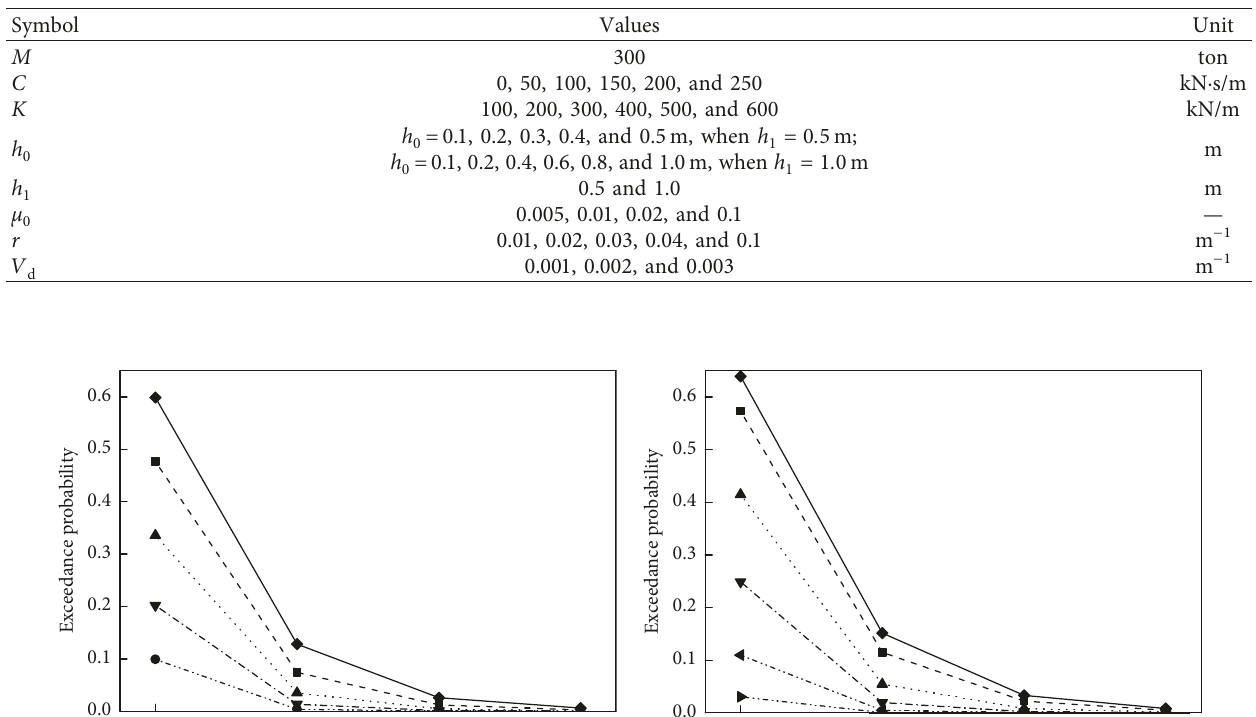
0 kN s/m, and PGA 0.8g (the horizontal ordinate DS1, DS2, DS3, and DS4 (cid:31) · (cid:31) 1 , h . 5m. (b) μ 0.005, r 0.0m 1 (cid:31) 0 0 (cid:31) 0.005, r (cid:31) 0.0m (cid:31) (cid:31) −